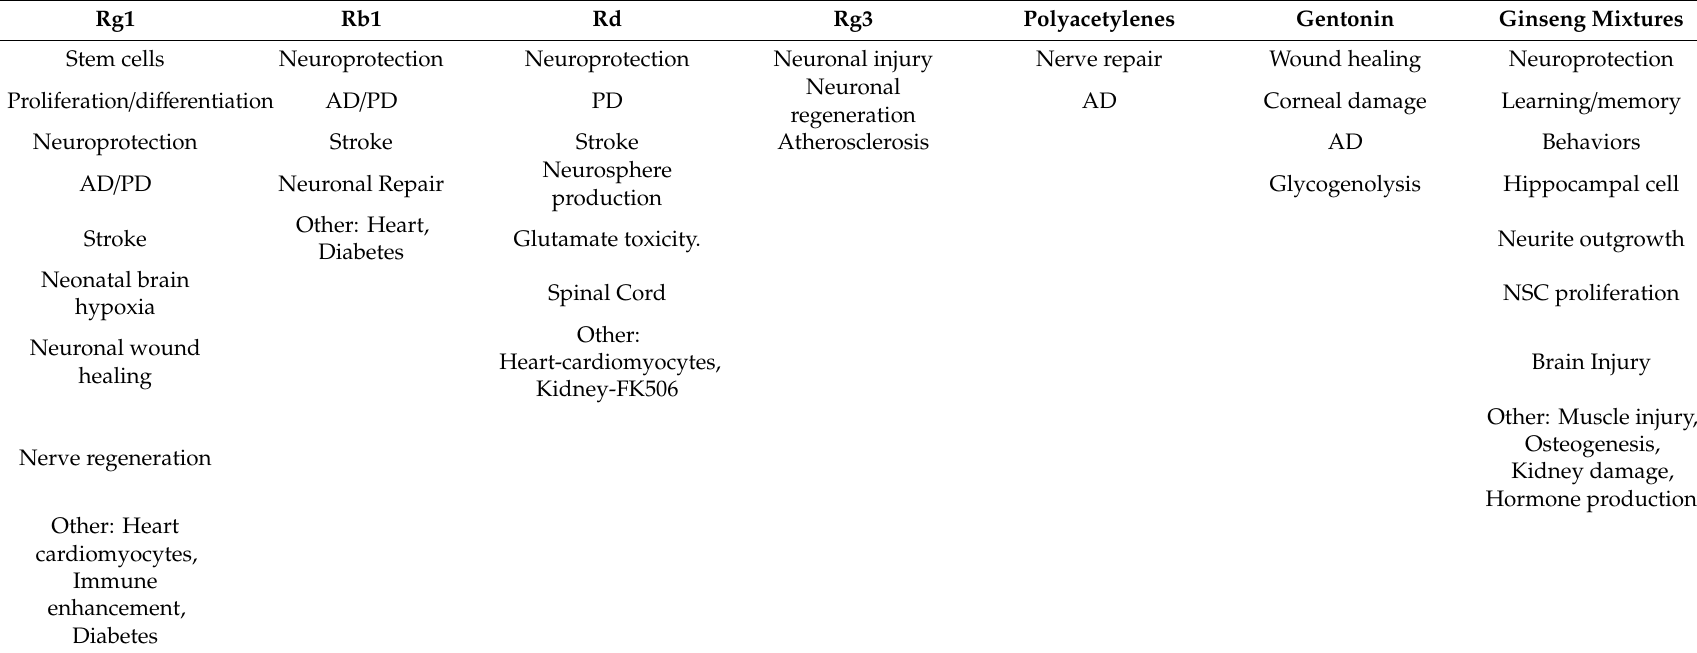
Table 2. Ginseng-induced hormetic dose responses by constituent /